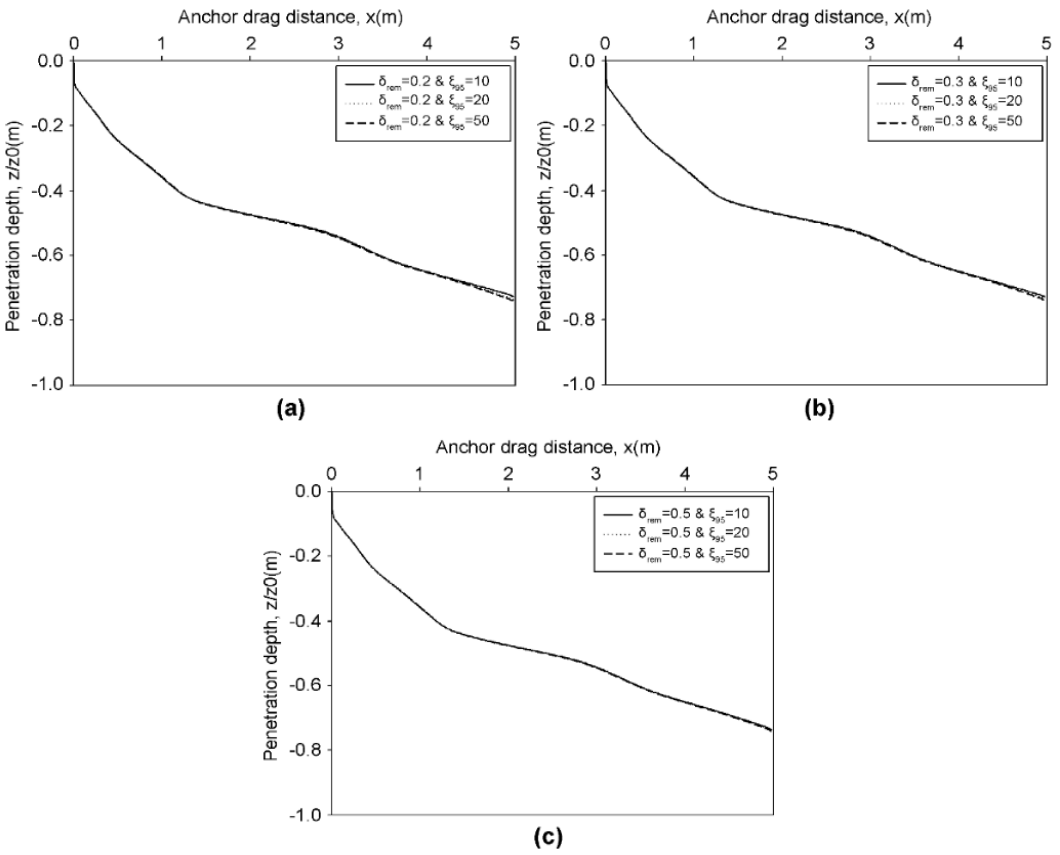
Figure 17. Anchor penetration depths of the TBSR–VUMAT model for a strain rate of 0.05 when δ rem is ( a ) 0.2, ( b ) 0.3, and ( c ) 0.5.